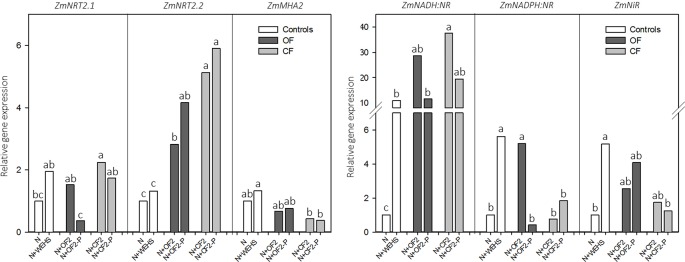
Real-time RT-PCR analyses of the main genes involved in the nitrate acquisition—ZmNRT2.1 and ZmNRT2.2 (coding for two high-affinity nitrate transporters), ZmMHA2 (coding for a PM H+-proton pump), ZmNADPH:NR and ZmNADPH:NR (coding for two isoforms of nitrate reductase), and ZmNiR (coding for nitrite reductase)—and performed on roots of maize plants exposed for 2 h to humic substances of different origin isolated in April. White bars, As controls, plants exposed to nutrient solution containing nitrate (0.5 mM Ca(NO3)2) with or without water-extractable humic substances (WEHS) (5 mg Corg L−1) (N+WEHS or N, respectively). Dark gray bars, Plants exposed to nutrient solution with nitrate and dissolved humic substances (DHS) (5 mg Corg L−1) isolated from organic farming (OF) soils. Light gray bars, Plants exposed to nutrient solution with nitrate and DHS (5 mg Corg L−1) isolated from conventional farming (CF) soils. The code name of samples is reported in Figure 1. Bars with the same letters are not significantly different at p ≤ 0.05.